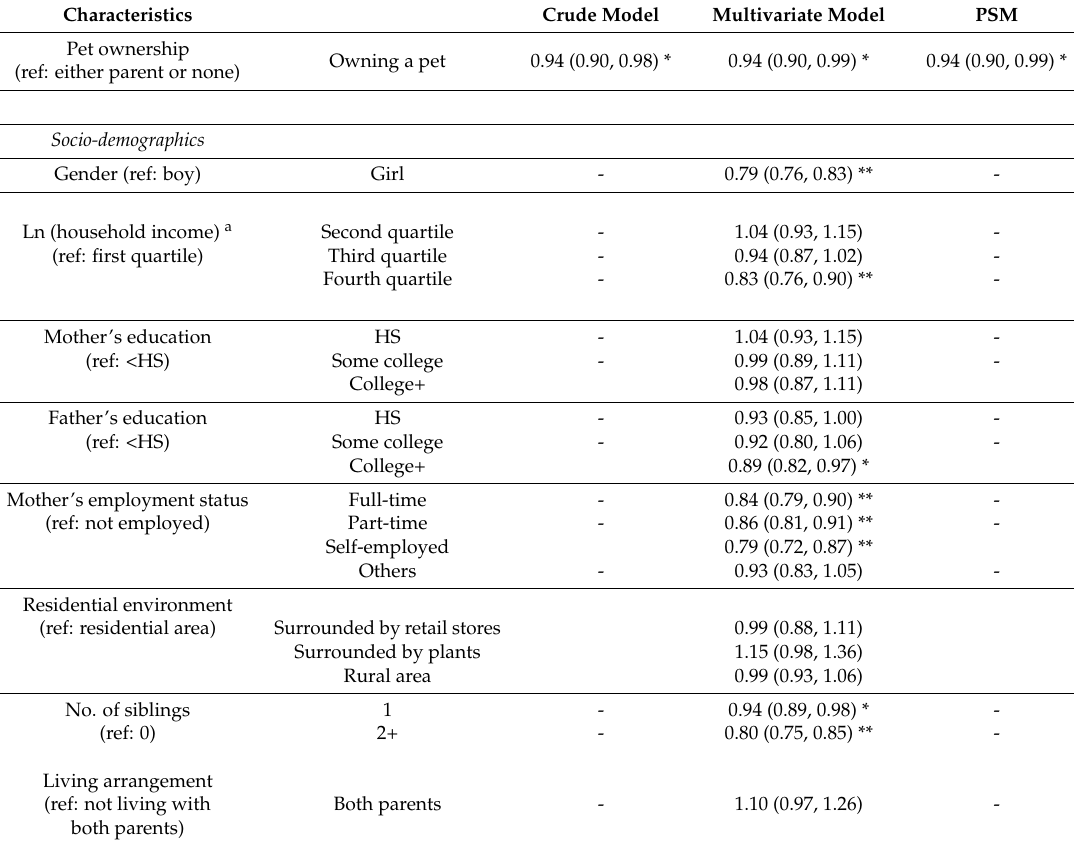
Table 4. Association between pet ownership and prevalence of poor emotional expression before and after propensity score matching ( N =